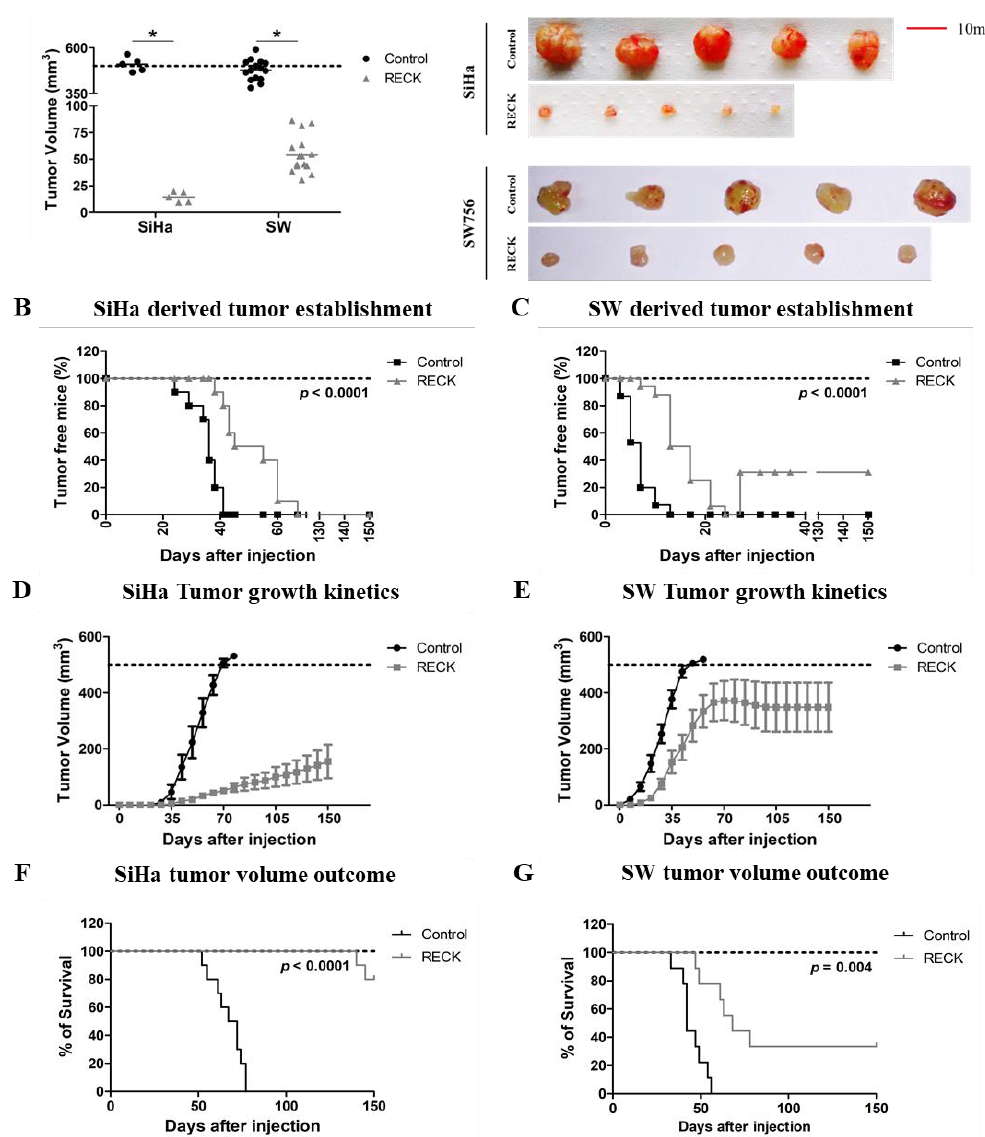
Figure 1. RECK over expression is associated with delayed SiHa and SW756 derived tumor establishment, reduced tumor growth and increased survival in nude mice. ( A ). Differential tumor growth experiment in nude mice. Here, the experiment ended once most of the animals from the control group presented tumors with 500 mm 3 . ( B – G ). The effect of RECK over expression on cervical cancer derived cells tumor establishment and overall survival was assessed in vivo. SiHa ( B , D , F ) and SW756 ( C , E , G ) cells over expressing RECK were subcutaneously injected in nude mice (2 × 10 6 cells/mouse). Tumors were identified as established once they were measurable with a manual caliper and the kinetics of tumor establishment for each of the cell lines tested are illustrated in B and C. D and E. Representative data from a tumor growth kinetics experiment. Tumor volume was measured weekly for at least 150 days. Overall survival was determined as each animal presented a tumor volume of 500 mm 3 during the 150 days of experiment (F and G). * p < 0.05 by Mann–Whitney (1A), Log rank (1B, 1C, 1F and 1G) or two-way ANOVA (1D and 1E)